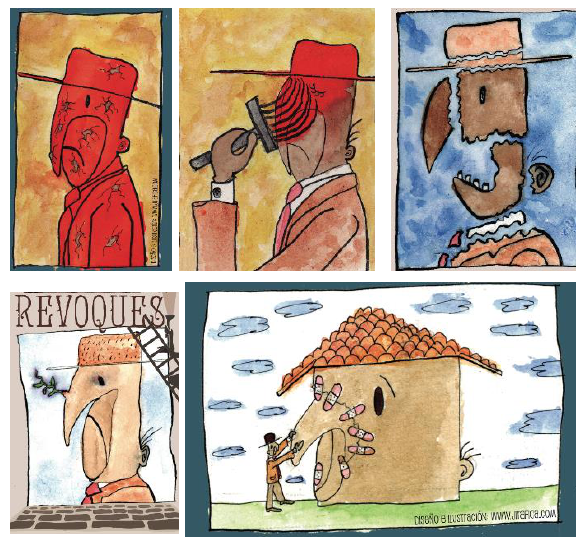
Figure 4. Don Víctor personified in